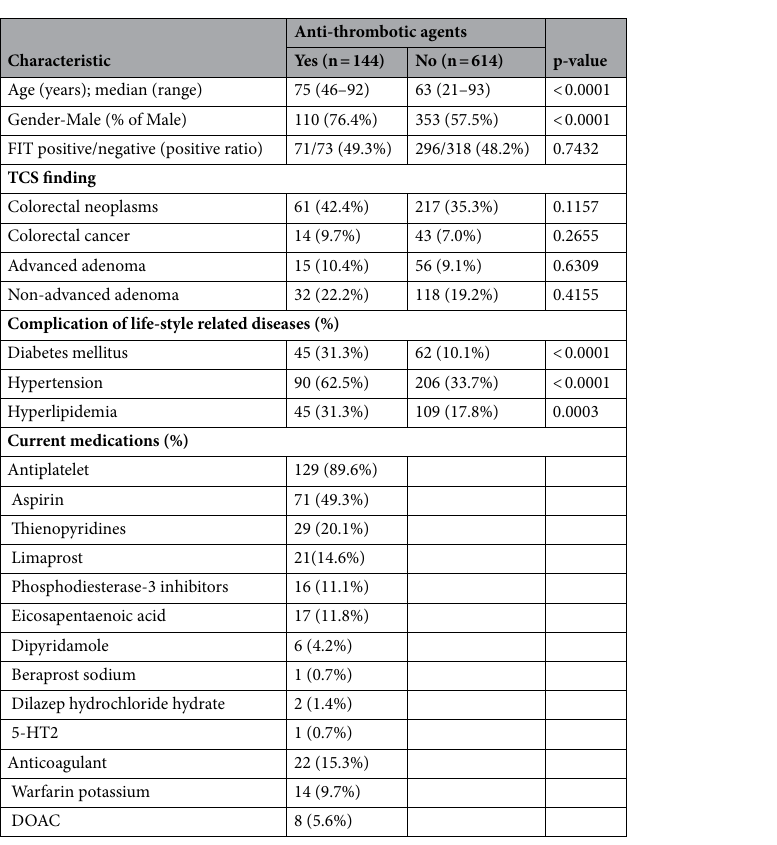
Table 1. Clinical characteristics of the 758 patients who underwent both fecal immunochemical test and total